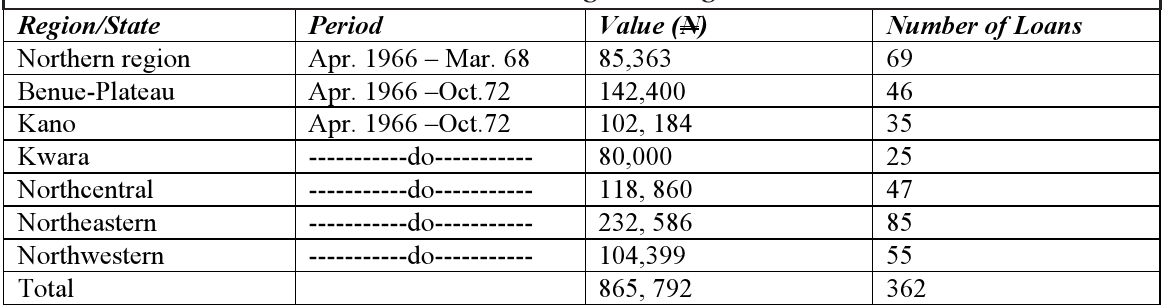
Table 3. Number and Value of Approved Loans to Small Business Establishments in Northern Region of Nigeria